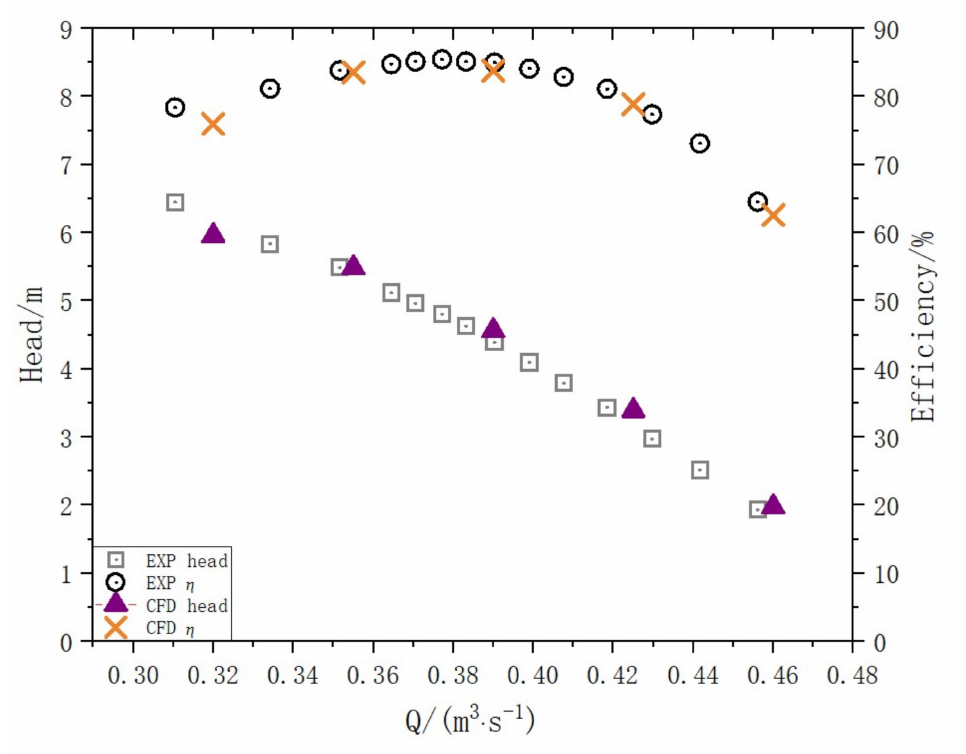
Figure 3. Test bench of axial-flow pump. ( a ) Test instruments. ( b ) Layout of test bench.